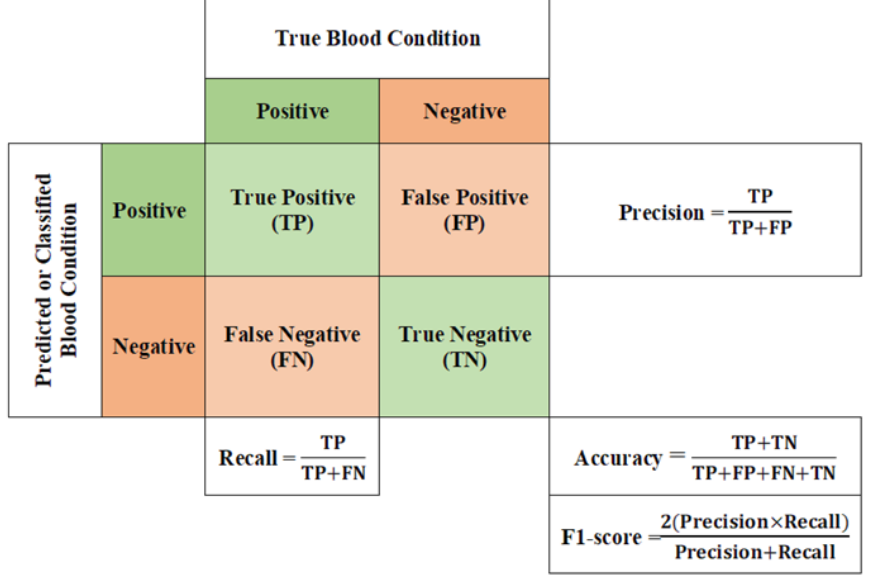
Figure 5. A confusion matrix and evaluation metrics for the microscopic blood image classification results presented in this